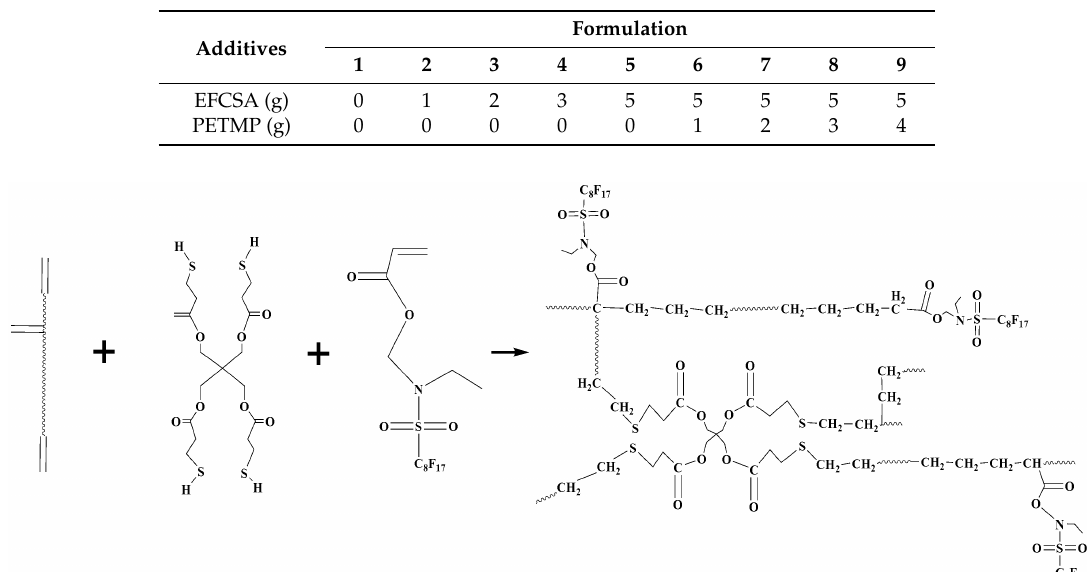
Table 2. Formulation of UV-curing coatings. HTPU (100 g), photoinitiator 184 (2 wt